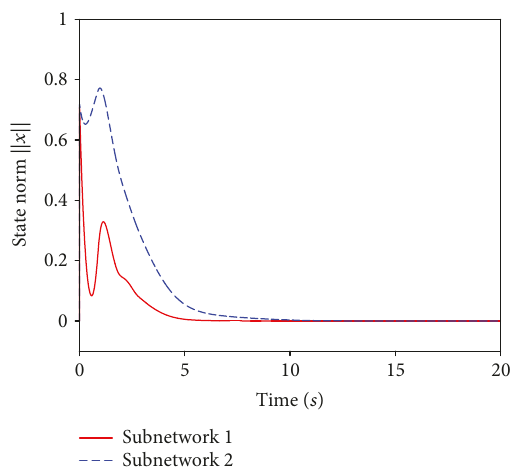
Figure 9: State norm responses of the subnetworks of the considered SNNs for Example 2.